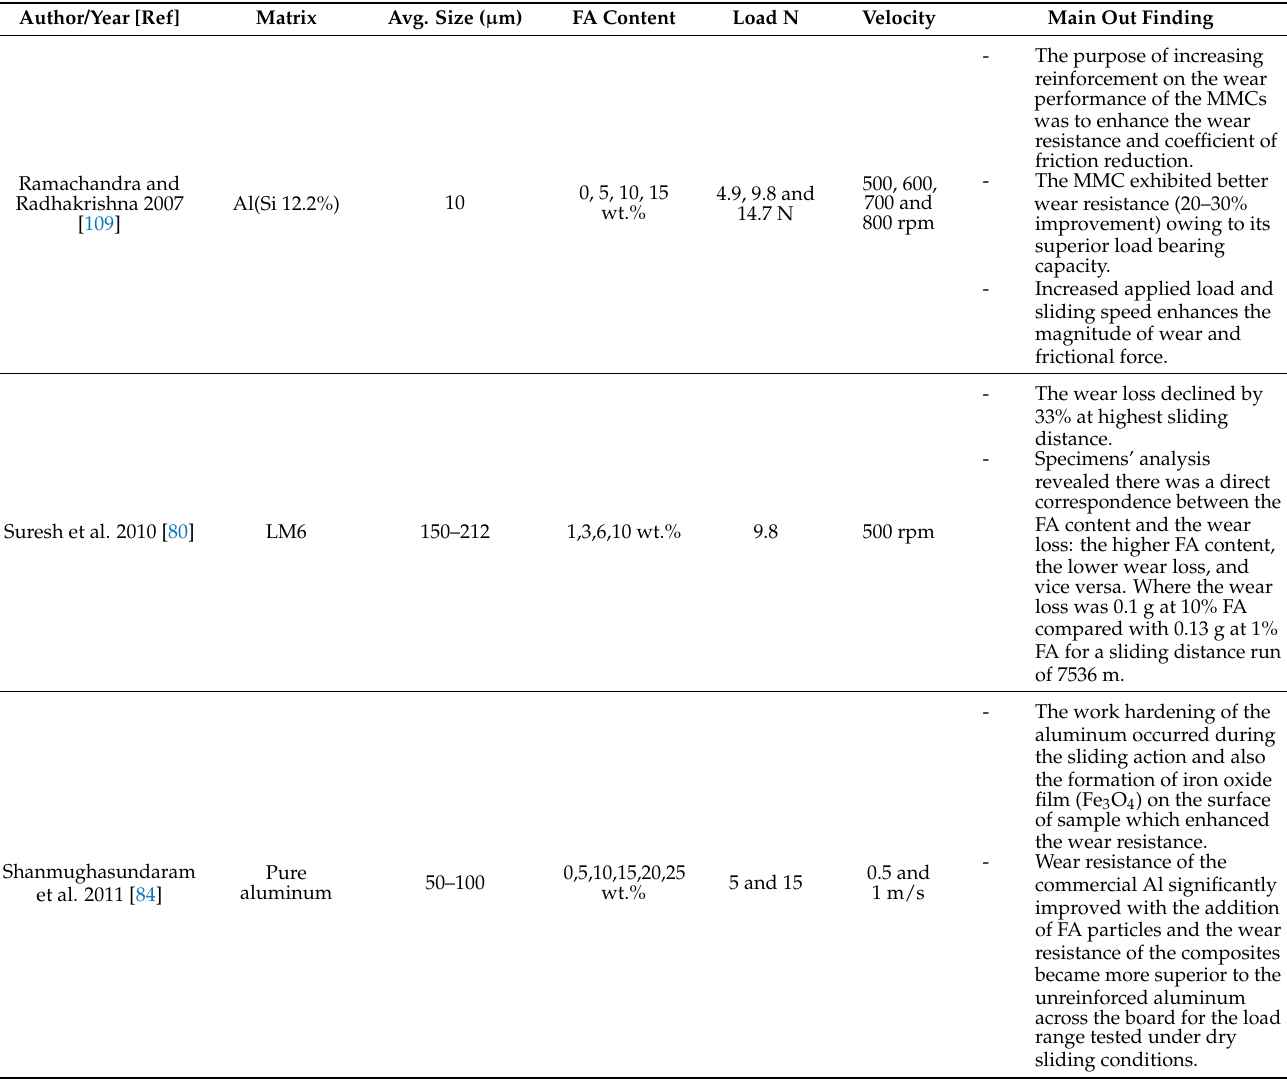
Table 2. Investigations regarding wear behavior of Al-FA